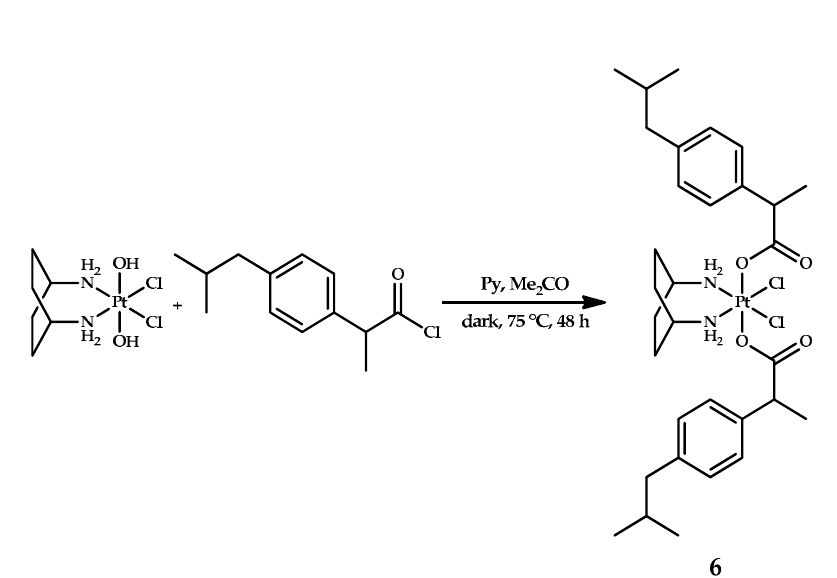
Figure 5. Synthesis of kiteplatin-based platinum(IV) prodrug 6 with two ibuprofen moieties as axial ligands.